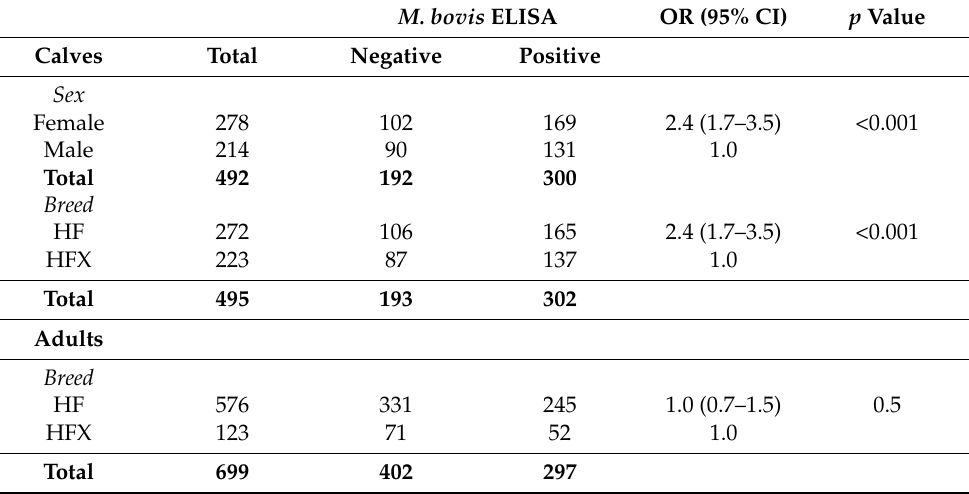
Table 3. Test of association of intrinsic factors on M. bovis positivity by ELISA testing in calves and adults. M. bovis